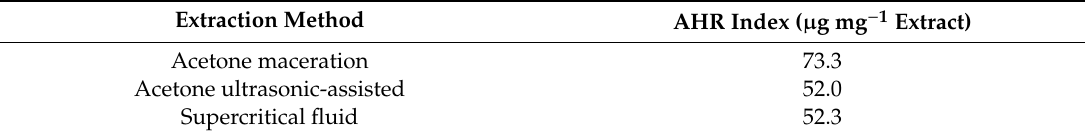
Table 1. Quantification of 7 α -Acetoxy-6 β -hydroxyroyleanone (AHR) in di ff erent P. grandidentatus extracts.